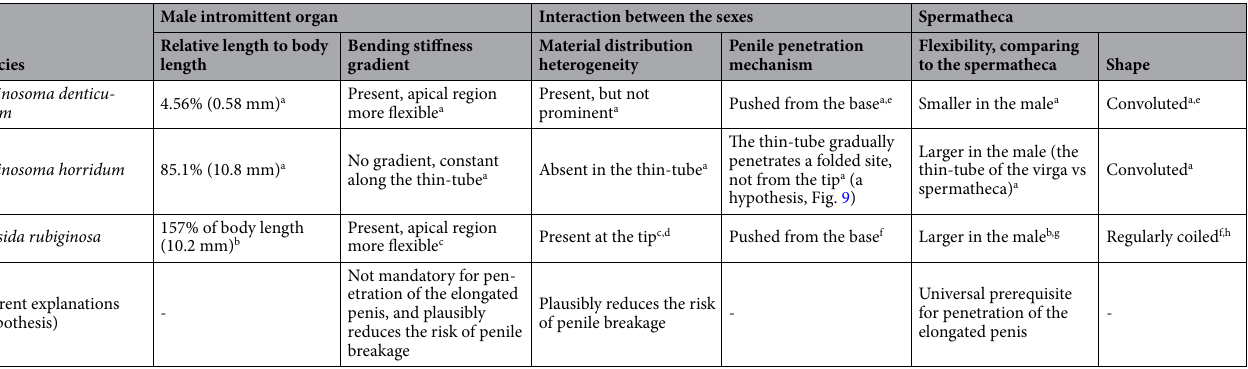
Table 2. A c omparison of the penetration mechanics between Echinosoma genitalia and Cassida rubiginosa genitalia documented and hypothesised in the present and previous studies. a The present study, b